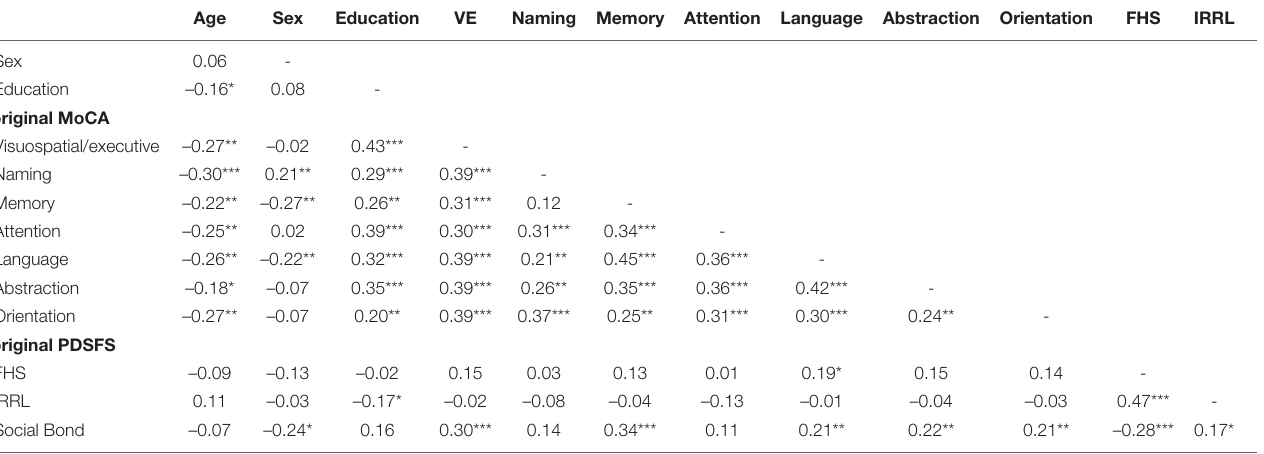
TABLE 7 | The Spearman rho correlation between the MoCA domains, the PDSFS factors, and demographic variables.